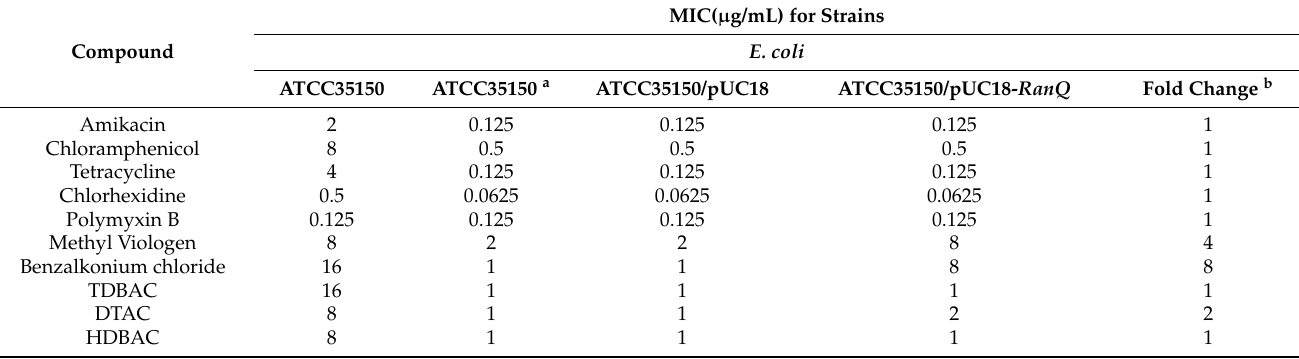
Table 4. MICs of various antimicrobial agents for deleted E. coli (ATCC35150/pUC18 and ATCC35150/pUC18- RanQ ) strains used in this